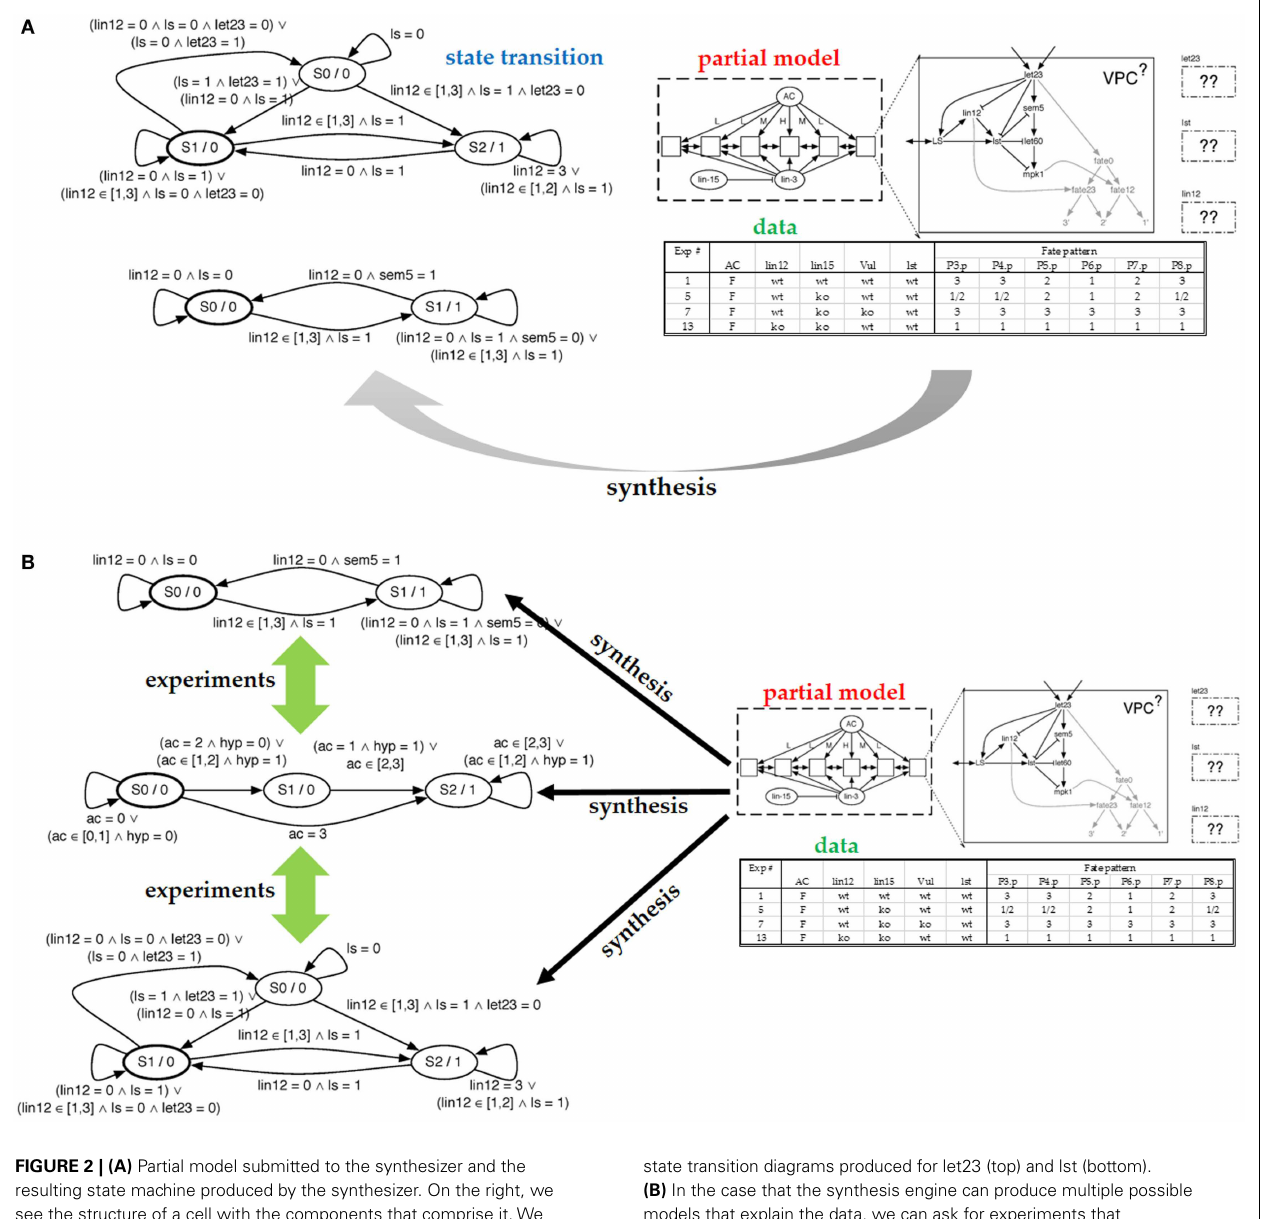
FIGURE 2 | (A) Partial model submitted to the synthesizer and the resulting state machine produced by the synthesizer. On the right, we see the structure of a cell with the components that comprise it.We see the configuration of the six cells and the communication allowed between them. Finally, we include some of the experimental data used to specify which models are correct. On the left, we see the resulting